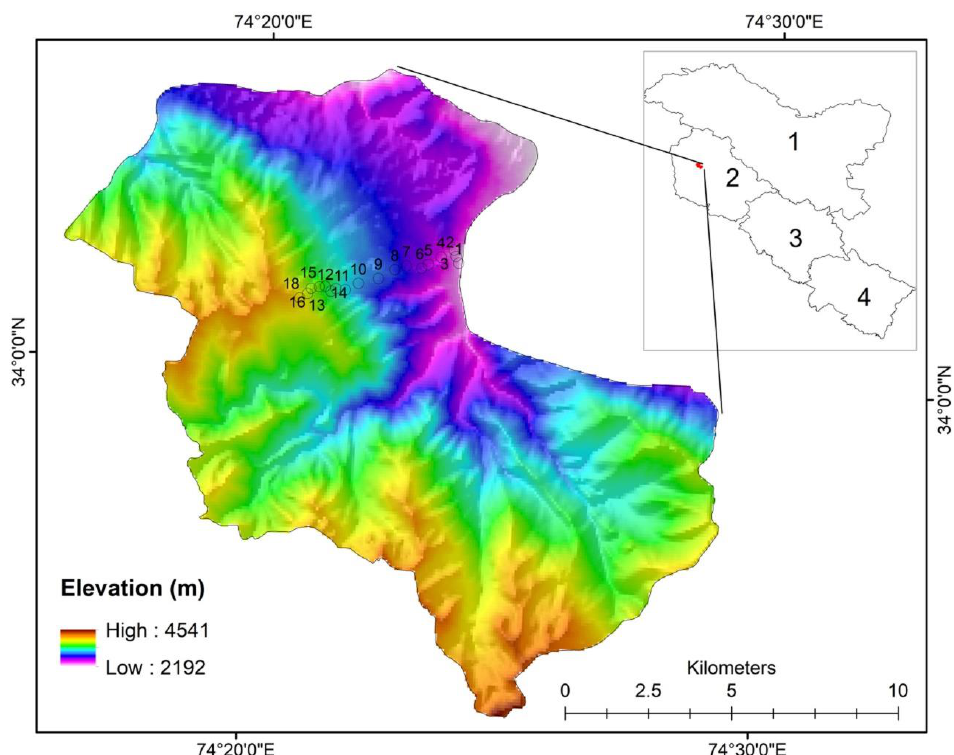
Figure 1. Location of study area showing sampling sites.